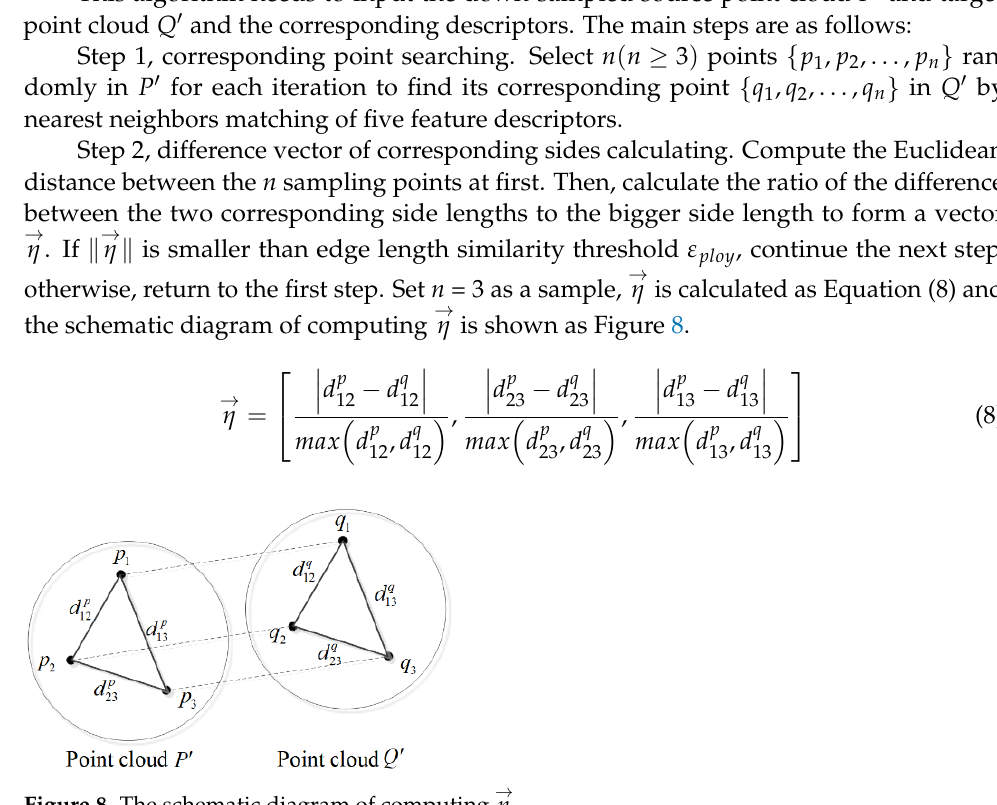
Figure 8. The schematic diagram of computing η